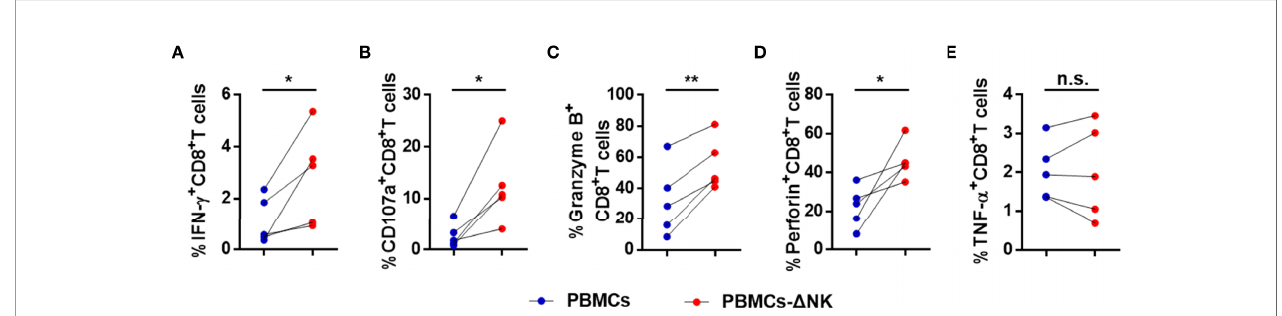
FIGURE 6 | CD8 + T cell responses are suppressed in a NK cell-dependent manner in active CHB patients. PBMCs or PBMCs depleted of NK cells (PBMCs- D NK) were cultured in vitro and stimulated with HBV peptide (core18-27) for 10 days. The production of the cytokines IFN- g , TNF- a , CD107a, granzyme B, and perforin (A – E) by CD8 + T cells was analyzed. Results are expressed as the mean ± SEM, and the number of samples (n) in each group was ≥ 3. A paired t-test was used to compare paired samples. *P < 0.05; **P < 0.01; n.s., not signi fi